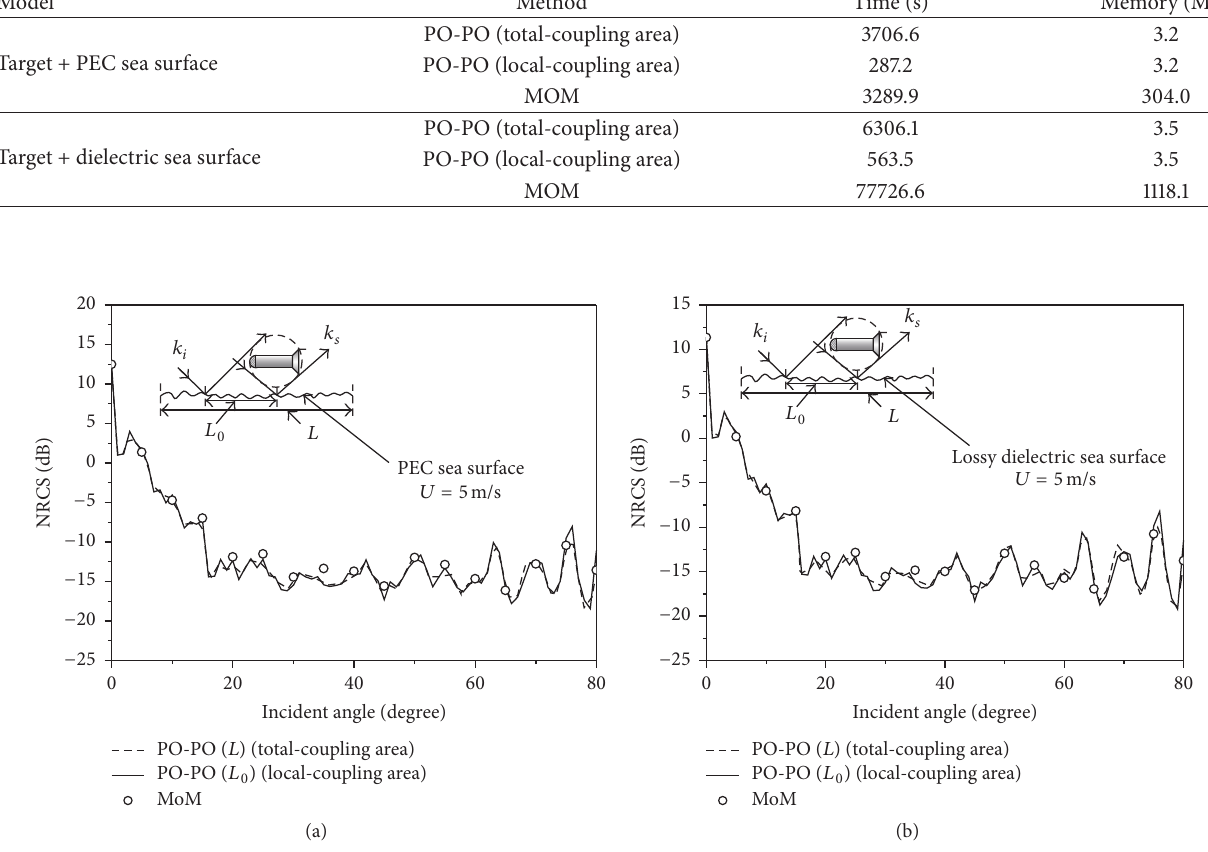
Figure 3: Comparison of NRCS by MOM and PO-PO: (a) PEC sea, (b) dielectric